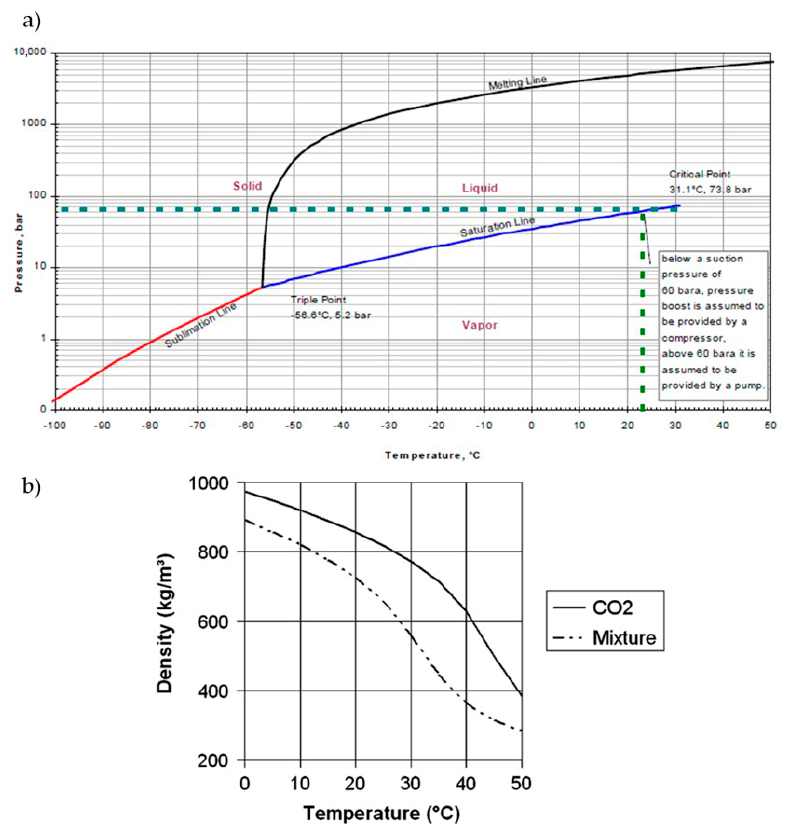
Figure 9. ( a ) CO 2 phase diagram; ( b ) difference in density of pure CO 2 and CO 2 rich mixture [95% CO 2 /3% N 2 /2% O 2 ] at 100 bar. International Energy Agency (IEA) [Woodhill] (2002) Pipeline transmission of CO 2 and energy transmission study-report. All rights reserved [39].